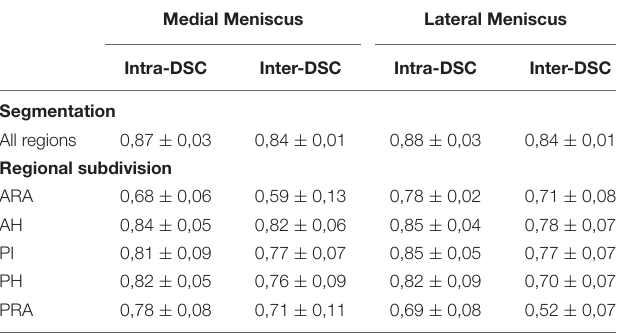
TABLE 2 | Inter- and intra-observer variation quantified using the Dice Similarity Coefficient (DSC) for both, manual segmentation and subsequent regional division of the medial and lateral meniscus reported as mean ± standard deviation (ARA, anterior root attachment; AH, anterior horn; PI, pars intermedia; PH, posterior horn; PRA, posterior root